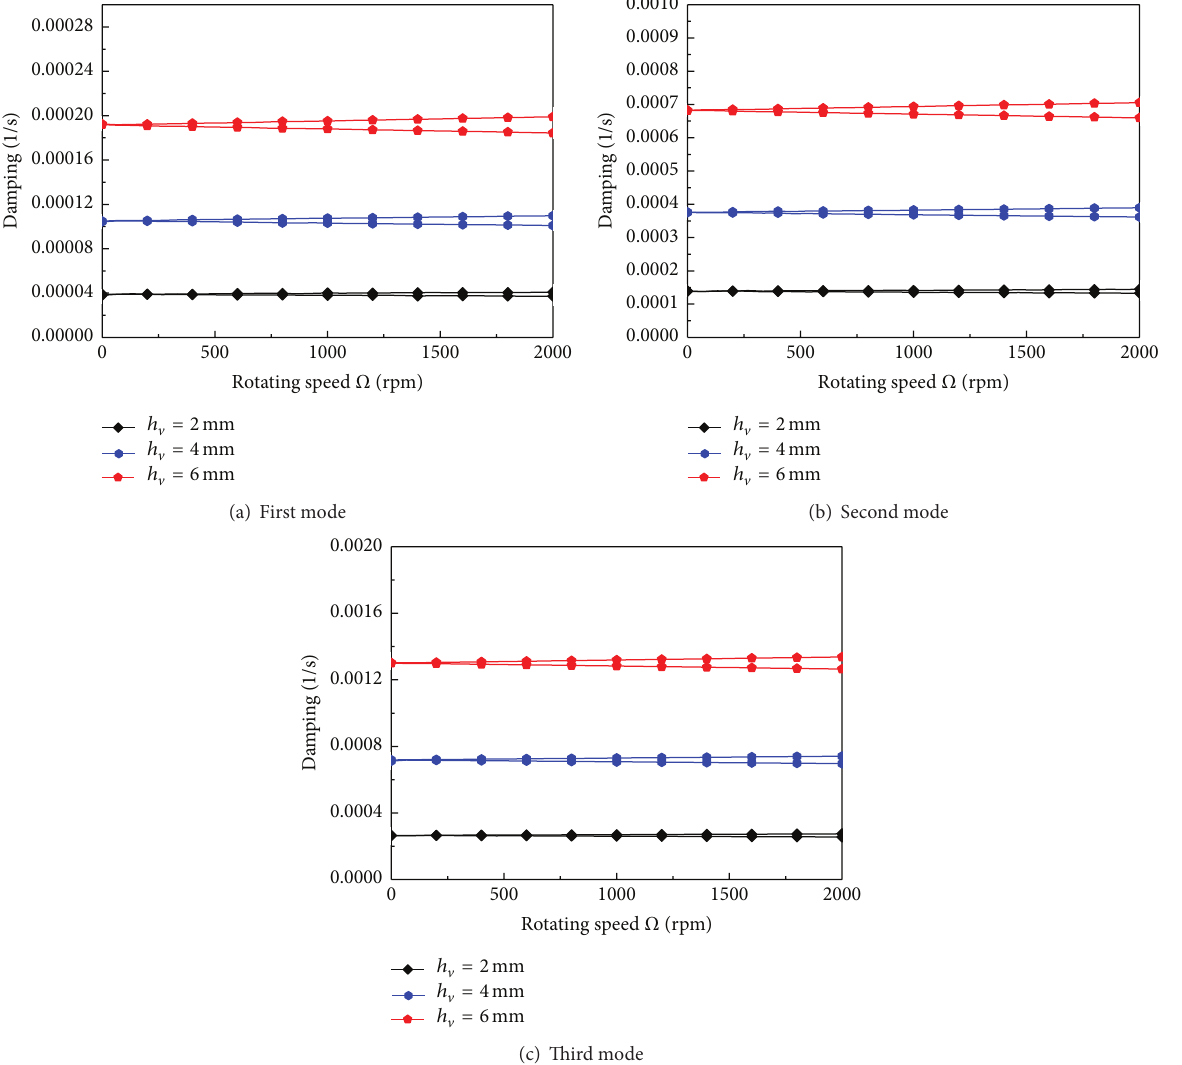
Figure 9: The first three modal dampings versus rotating speed for various thicknesses of viscoelastic damping layer ( ℎ 𝑐 = 2 mm, 𝜃 = 60 ∘ ).